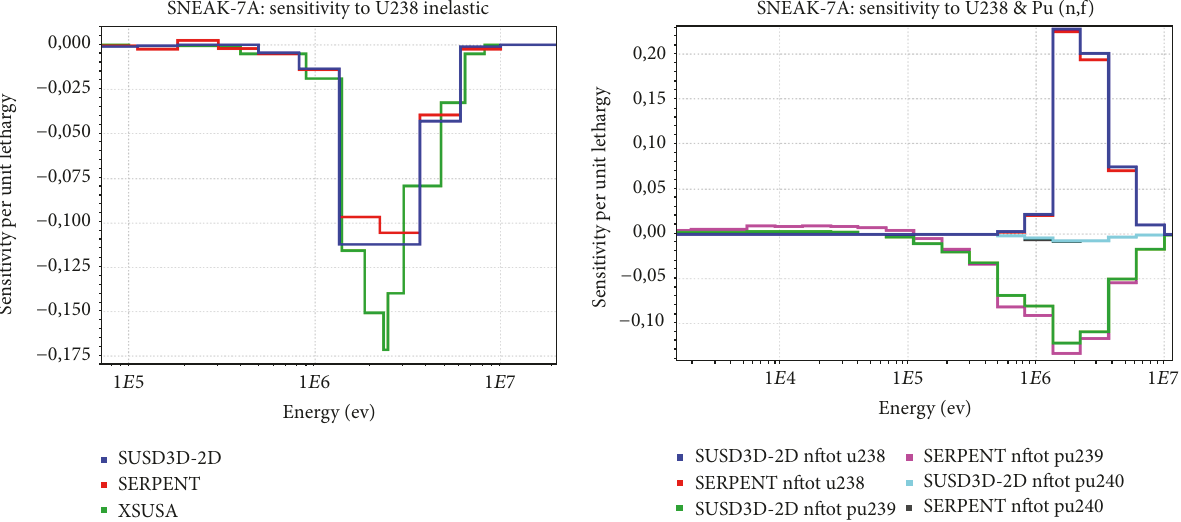
Figure 8: Sensitivity of 𝛽 eff to 238 U inelastic and 238 U, 239,240 Pu fission cross-sections, calculated using the SUSD3D, XSUSA, and SERPENT codes for the SNEAK-7A benchmark.